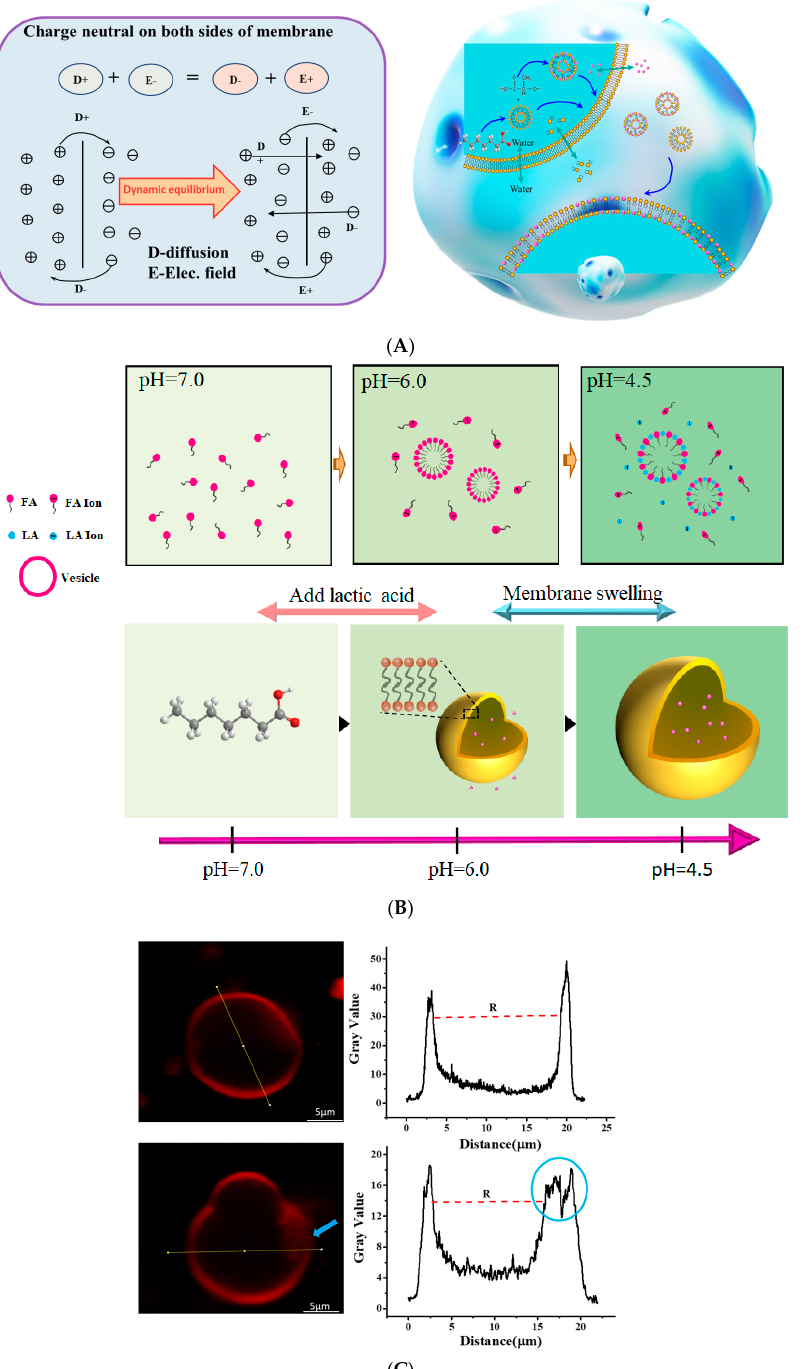
Figure 6. Schematic diagram of homogeneous FA vesicles exhibit swelling properties when subject to LA conditions. ( A ) The charge was neutral on both sides of semi-permeable membranes. ( B ) After the addition of LA, the system pH was changed by the dissociation of lactic acid, and gradually reassem- bled to LA/FA composite vesicles. ( C ) The fatty acid vesicles are labeled with fluorescent probes, and the structural changes of the vesicle membrane can be analyzed according to the fluorescence intensity. With the change of lactic acid in the solution environment, the vesicles bud and swell in radius. When the vesicle is a spherical structure, the fluorescent label on the membrane surface is the strongest, and the middle is the vesicle diameter R. When vesicles appear indented, the membrane surface fluorescence decreases to form